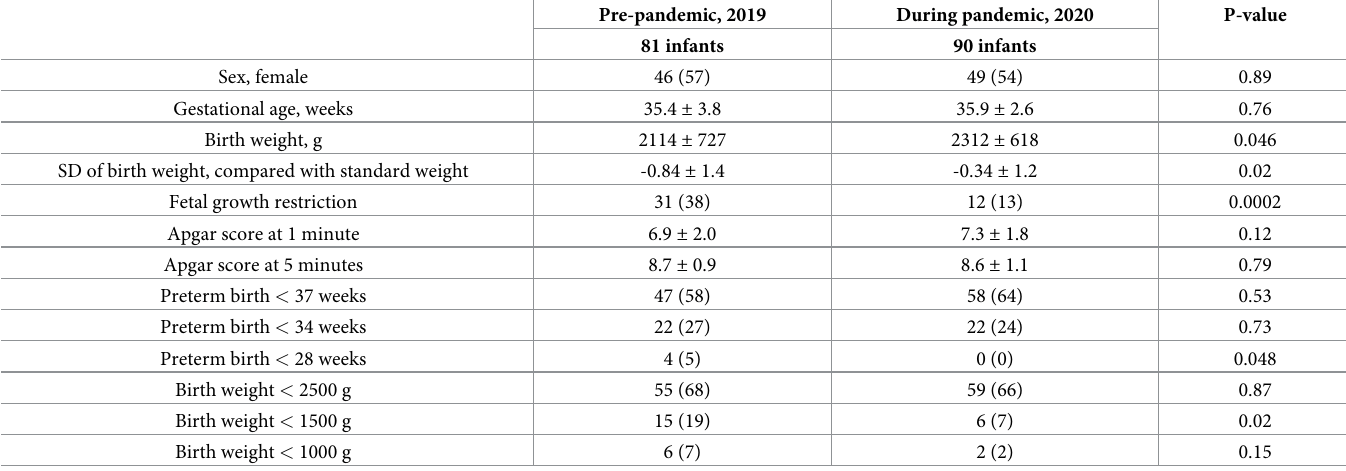
Table 1. Baseline characteristics of infants in this study.